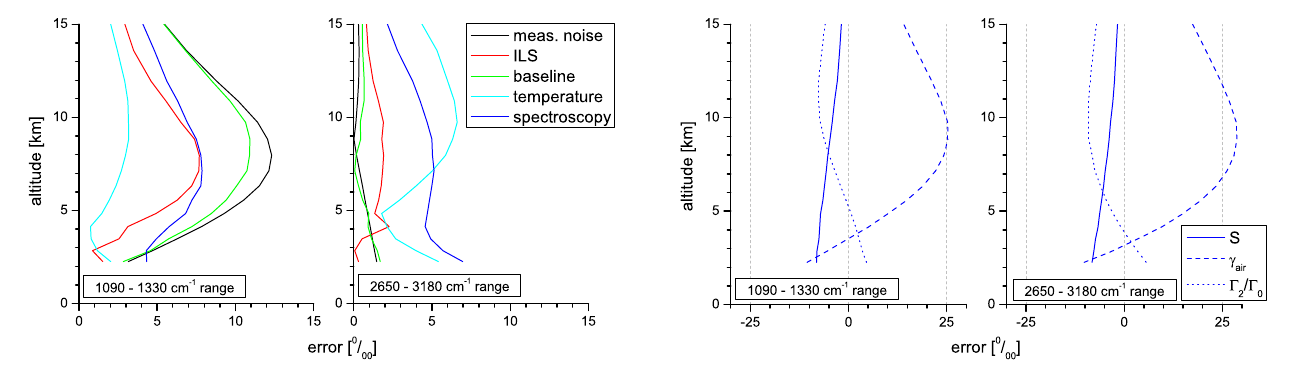
Fig. 8. Estimated H 2 O systematic profile errors for the retrievals in the four different spectral regions. Solid line: line strength ( S ) uncertainty; Dashed line: pressure broadening coefficient ( γ air ) uncertainty; Dotted line: speed-dependence strength ( Γ 2 / Γ 0 ) uncertainty.